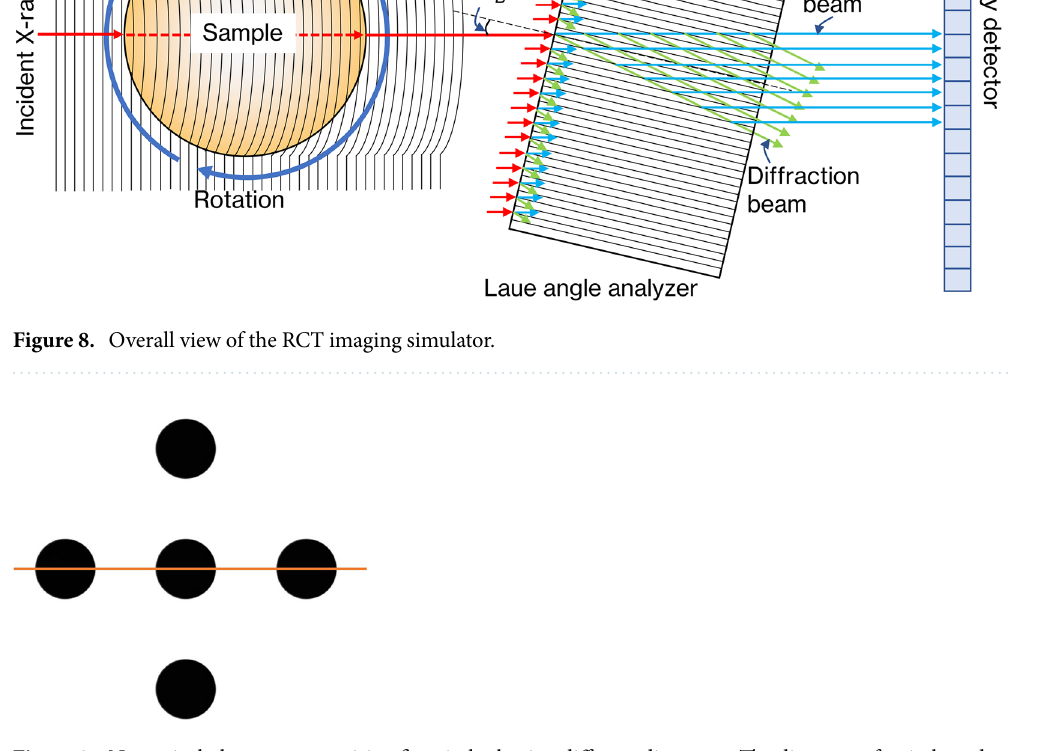
Figure 9. Numerical phantom comprising five circles having different diameters. The diameter of a circle and the distance between adjacent circles are